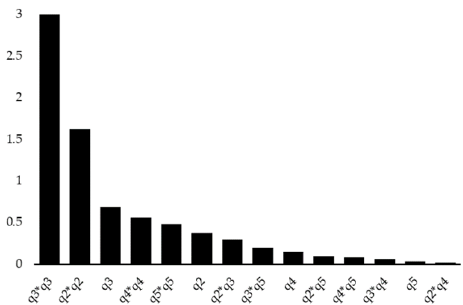
Figure 6. VIP values of items in M.